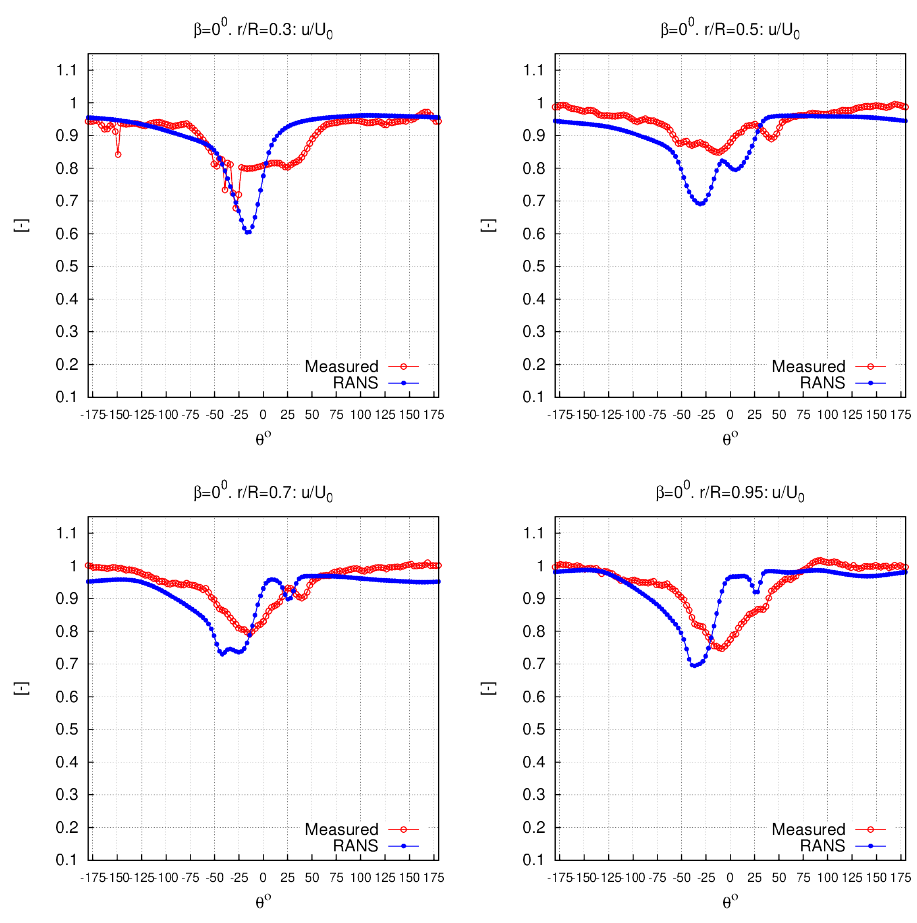
Figure 5. Nominal wake of the model hull in straight-ahead motion: axial velocity components by PIV (red plots) and RANS (blue plots) at radial sections ( r / R = 0.3;0.5;0.70;0.95 from left to right, top to